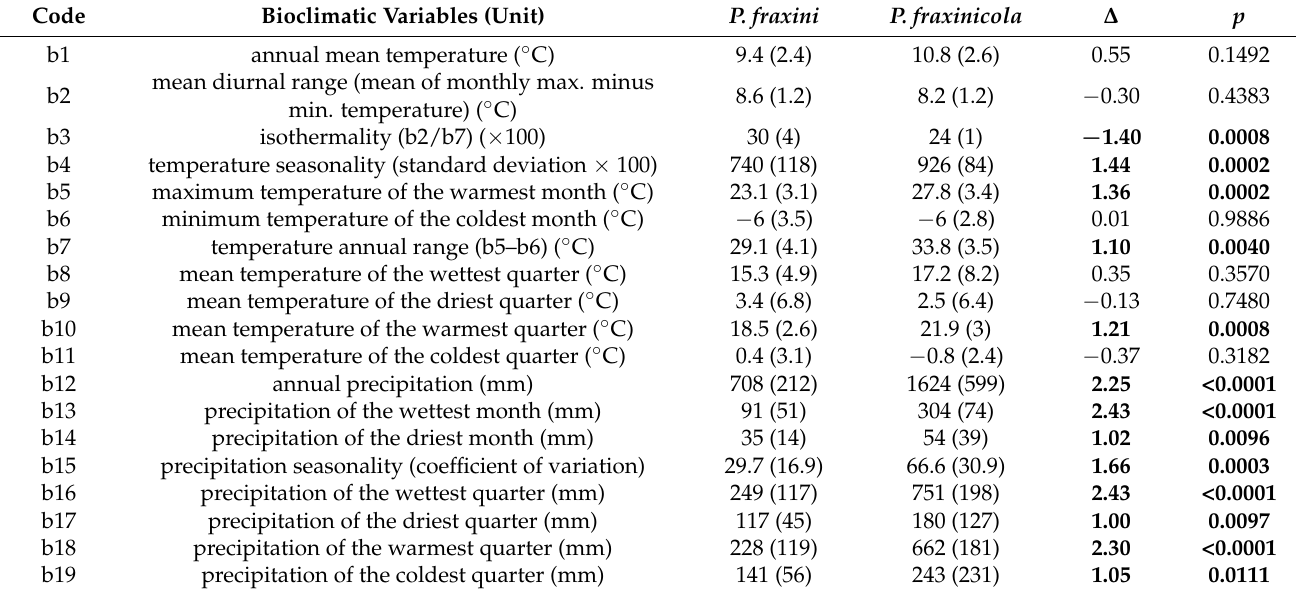
Table 1. Mean values and standard deviations (in parentheses) of bioclimatic variables at collecting sites of Phyllactinia fraxini and P. fraxinicola . Results of randomization tests comparing differences in standardized mean values of bioclimatic variables ( ∆ ) are displayed along with corresponding probabilities ( p ). Results significant at α = 5% are highlighted in